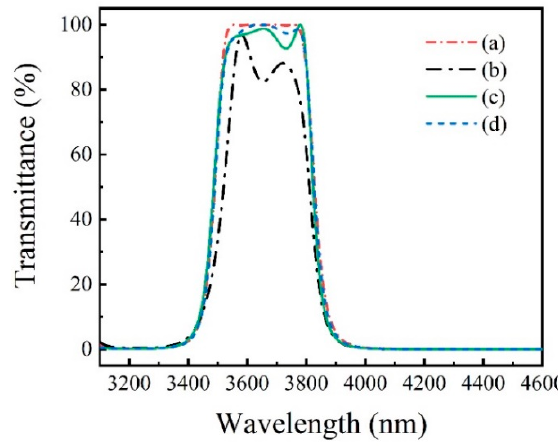
Figure 16. Computed and measured transmittance of the F-P filter for comparison. ( a ) Theoretical spectrum, ( b ) simulated spectrum (simulated by applied actual thickness), ( c ) simulated spectrum (simulated by applied designed spacer layer thickness), and ( d ) simulated spectrum (based on c, further simulated by applied designed spacer layer and designed layer 1 and layer 4 thickness).